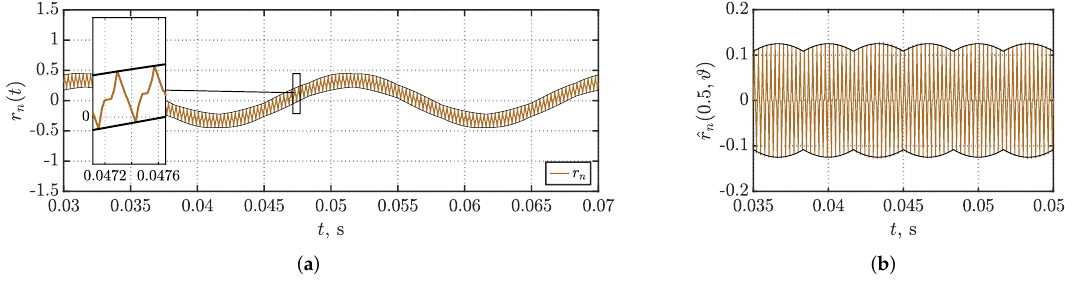
Figure 11. Profile and primary (black) envelope m = 0.5 and k = 1: ( a ) normalized neutral current; ( b ) normalized neutral current ripple.